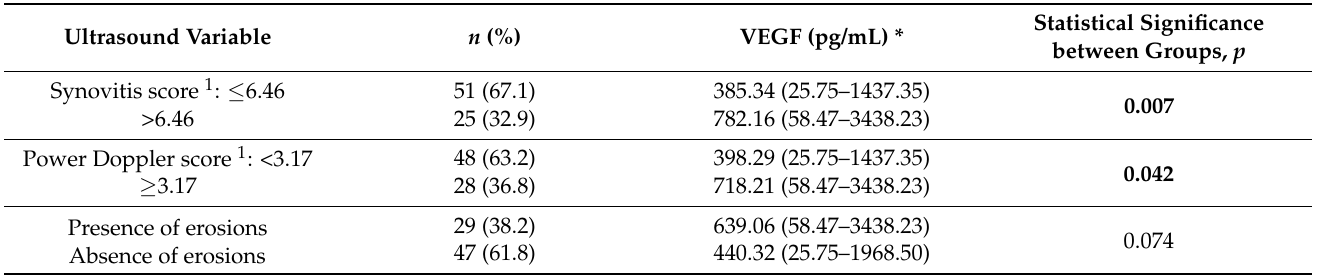
Table 8. VEGF level distribution between undifferentiated arthritis patient cohort in ultrasound